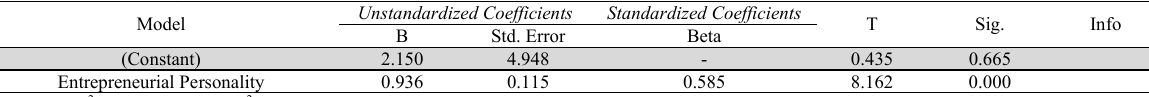
Table 1 MRA Model I Analysis Results